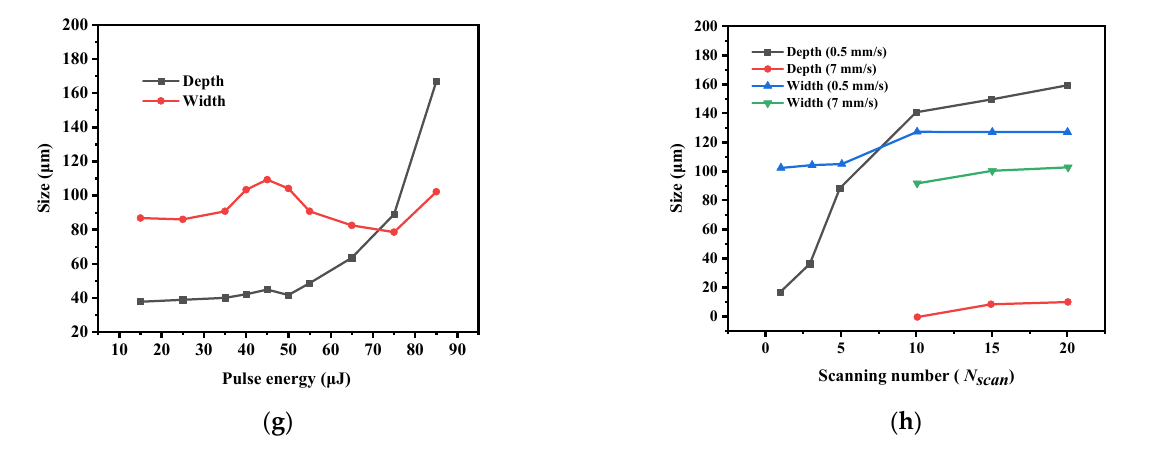
Figure 6. Schematic of laser ablation’s effect on the material: ( a ) in air; ( b ) with a liquid layer, reprinted with permission from [49], Copyright from Elsevier 2020; the change of the focus point induced by the optic effect of liquid layer; ( c ) in oil; ( d ) in water, reprinted with permission from [88,94], Copyright from Elsevier 2020, 2016; ( e ) ablation size volume of craters created on with oil film layer, reprinted with permission from [88], Copyright from Elsevier 2020; Sample depths and widths at various: ( f ) frequencies; ( g ) pulse energies; and ( h ) scanning numbers [100].